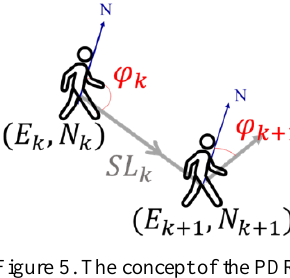
Figure 5. The concept of the